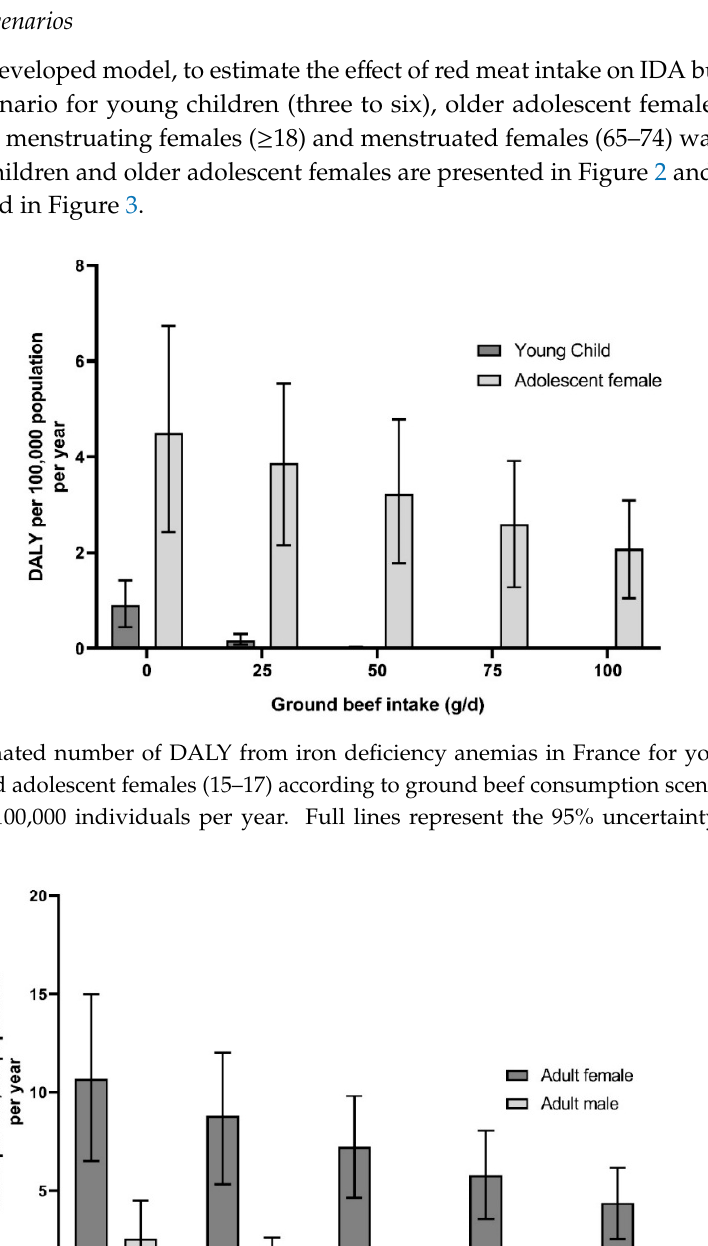
Figure 3. Estimated number of DALY from iron deficiency anemias in France for adult males and females according to ground beef consumption scenarios. Results expressed per 100,000 individuals per year. Full lines represent the 95% uncertainty around the mean value.